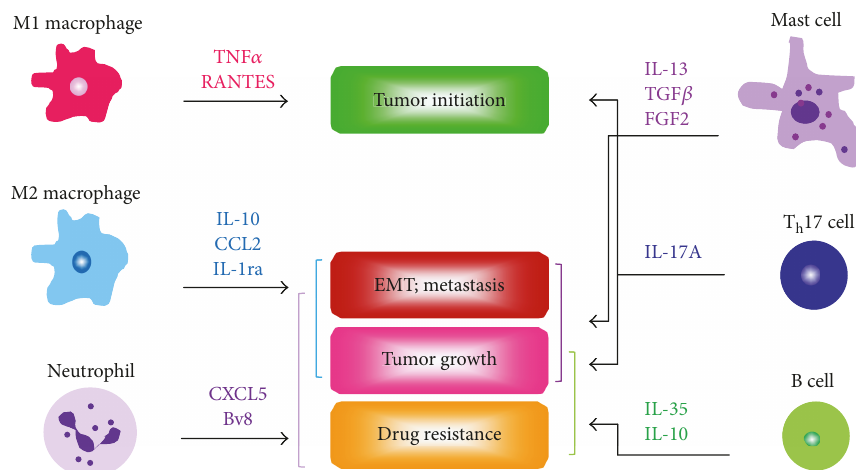
Figure 1: E ff ects of the cytokines secreted by di ff erent types of immune cells on tumor initiation, progression, and dissemination. Cytokines secreted by macrophages, neutrophils, mast cells, T 17 cells, and B cells directly lead to initiation and development of pancreatic and prostate h cancers. IL: interleukin; RANTES: regulated on activation, normal T cell expressed and secreted; TGF β : transforming growth factor β ; FGF2: fi broblast growth factor 2; EMT: epithelial mesenchymal